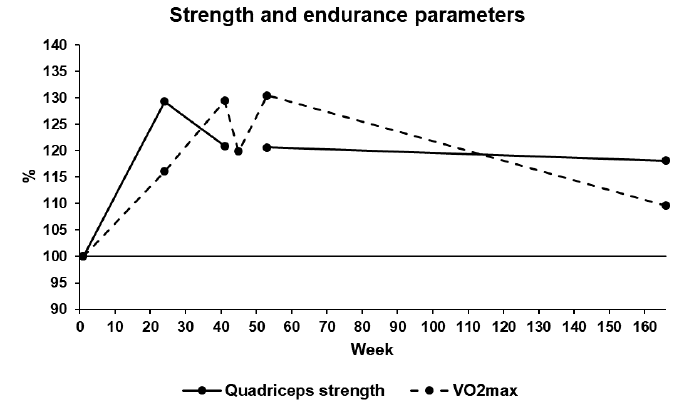
Figure 5. Evolution of strength and endurance parameters (quadriceps strength and maximal oxygen uptake (VO 2 max)) of the participant during the 38-month period of the uptake (VO 2 max)) of the participant during the 38-month period of the study.